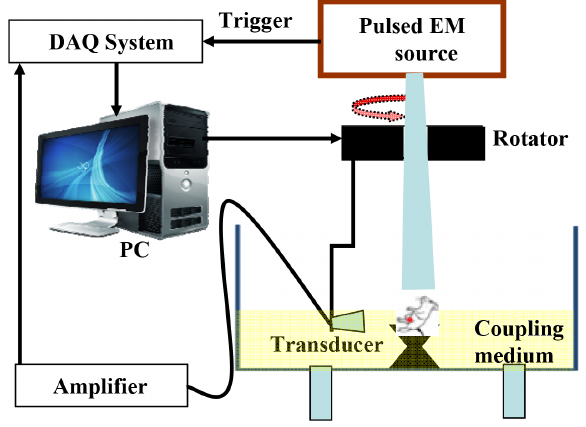
Fig. 1. Schematic of the PA/TA imaging systems. Pulsed EM source stands for laser or microwave. In PAT, water was used as a coupling medium, while transformer oil functioned as the coupling medium for TAT. DAQ: Data